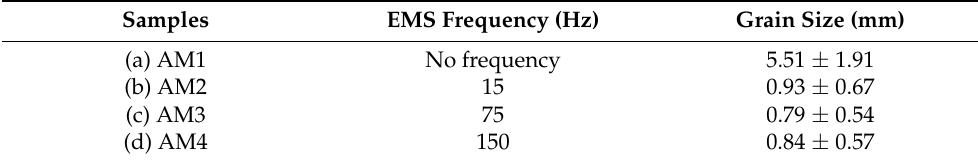
Table 2. Influence of EMS frequency on grain size.